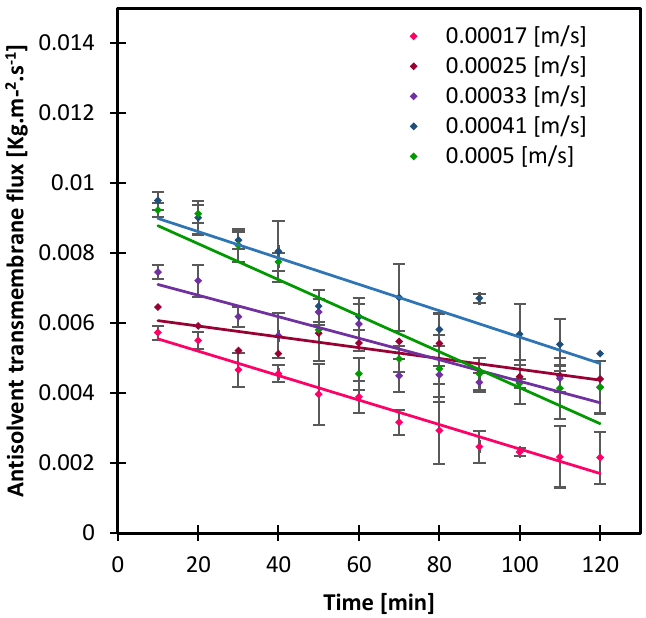
Figure 2. The mass transfer of the antisolvent through PP membrane as both the crystallizing and the antisolvent solutions, equally increased from 0.00017 to 0.0005 m/s. Lines are added to guide the eye.